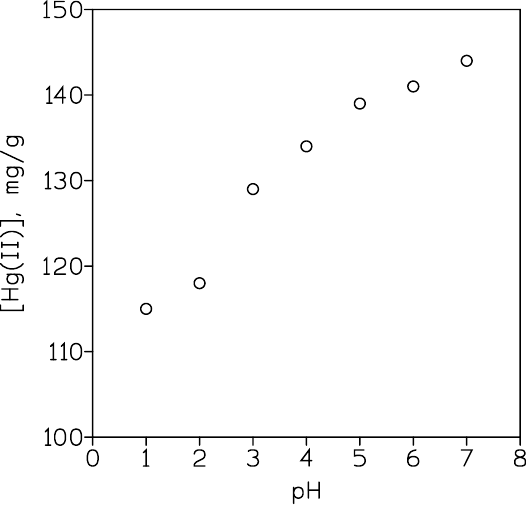
ff ect of pH on Hg(II) Figure 3. Effect of pH on Hg(II) adsorption. Figure 3. E